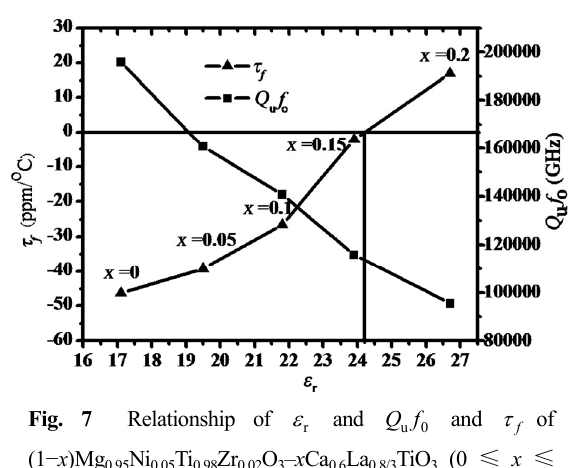
Fig. 7 Relationship of (1 − x )Mg 0.95 Ni 0.05 Ti 0.98 Zr 0.02 O 3 – x Ca 0.6 La 0.8/3 TiO 3 (0 ≤ x ≤ 0.2) ceramics as a function of